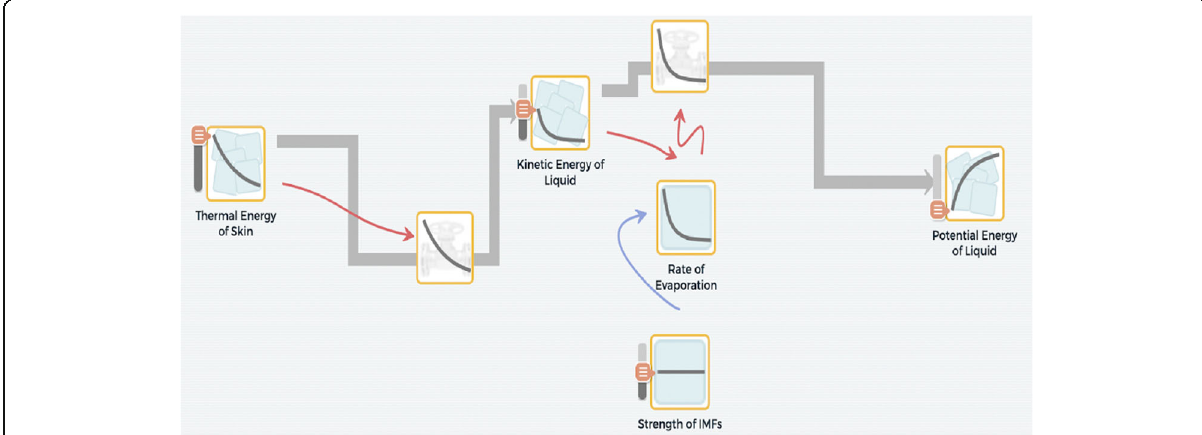
Fig. 1 Ideal model of evaporative cooling phenomenon. Note: This model of evaporative cooling focuses on how thermal energy from the skin (thermal energy of skin) is used to warm up the liquid (kinetic energy of liquid) and ultimately drive the process of evaporation (rate of evaporation), resulting in an increase in potential energy of that substance (potential energy of liquid in the form of a